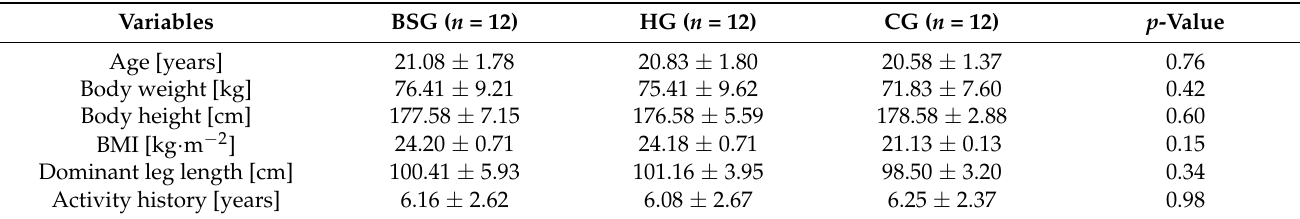
Table 3. Characteristics of the study groups at baseline (mean ± SD).